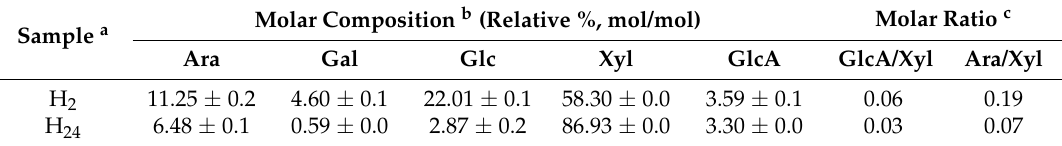
Table 2. Sugar composition of dimethyl sulfoxide (DMSO)-soluble hemicelluloses extracted from